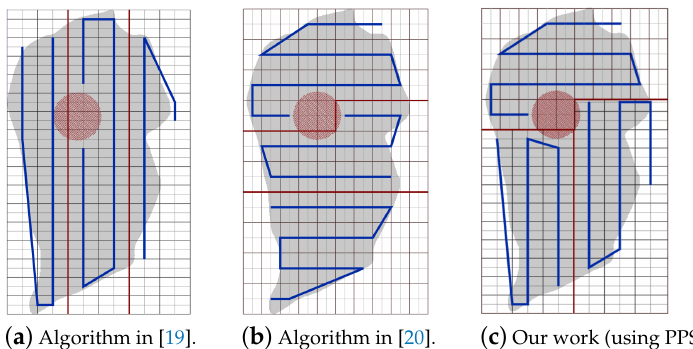
50.00% over PPS-W and by 42.85% over PPS-T. In PPS-L, the completion time is reduced by 10.30% and 14.99% over PPS-W and PPS-T, respectively. The gain in energy is 4.09% and 12.85% over